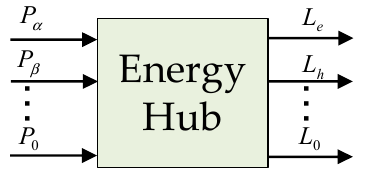
Figure 1. EH with inputs P α , P β , · · · , P 0 and outputs L α , L β , · · · , L 0